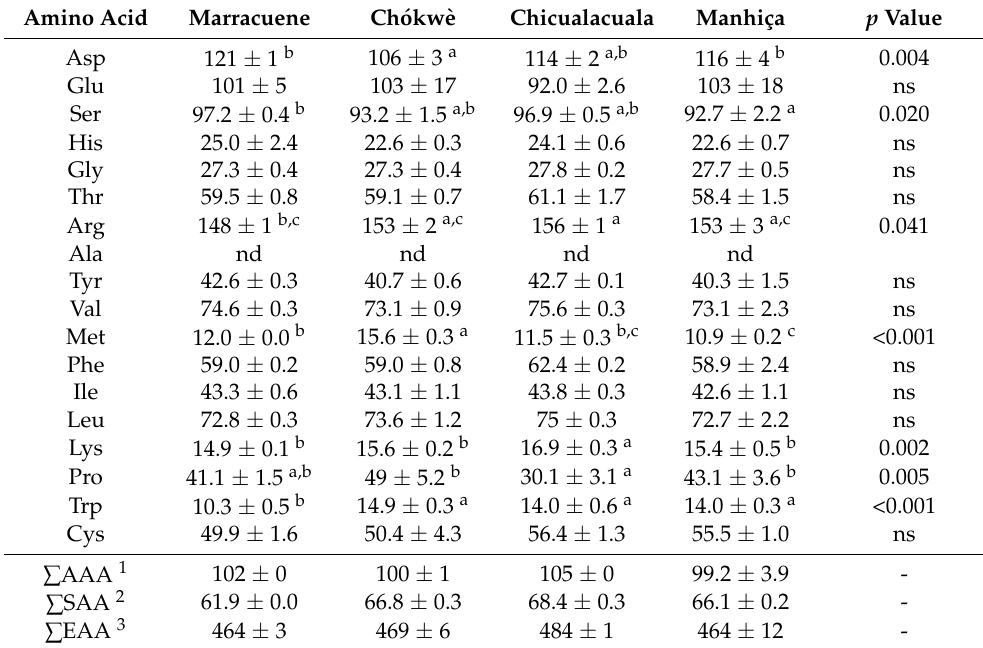
Table 4. Amino acids composition of protein (mg/g protein) from the S. madagascariensis fruit flour ( nfuma ) from four districts (Marracuene, Manhiça, Ch ó kw è and Chicualacuala) in south- ern Mozambique. Amino Acid Marracuene Ch ó kw è Chicualacuala